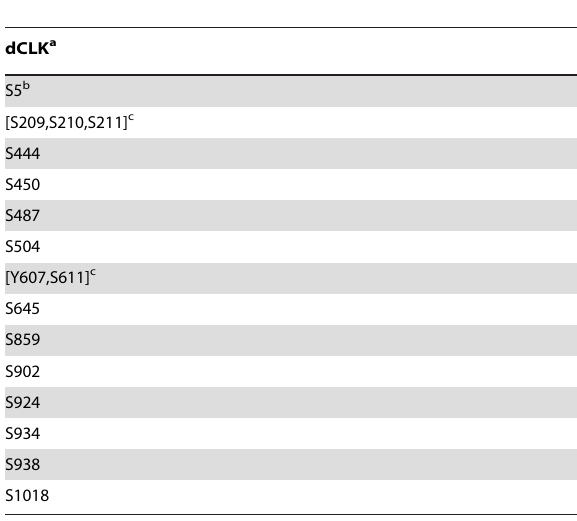
Table 1. Identification of phosphorylation sites on dCLK produced in Drosophila S2